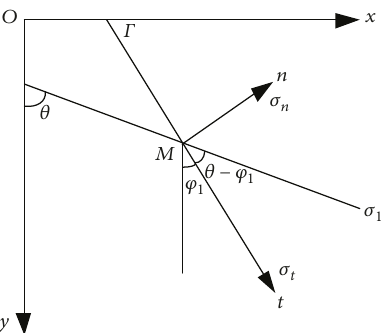
Figure 1: Basic coordinate system and noncharacteristic line stress boundary.